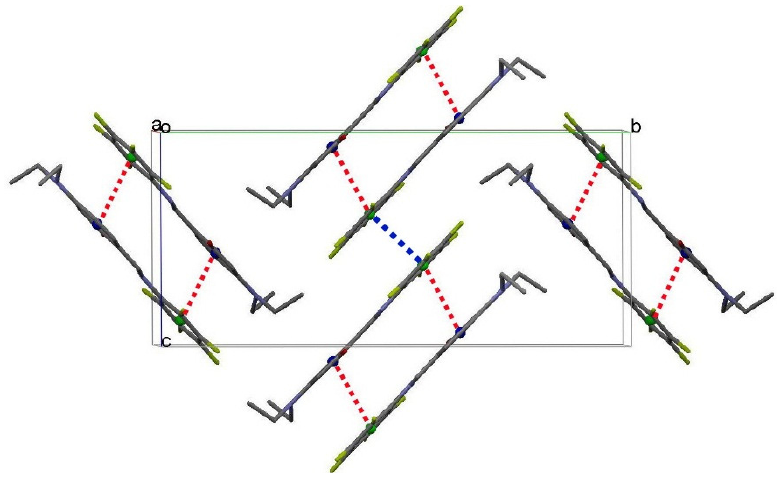
Figure 5. A stereoview of part of the crystal structure of 4 , viewed along the a -axis (all hydrogen atoms are omitted for clarity). Red and blue dashed lines denote the intermolecular π  π interactions. C g1 (blue circles) and C g2 (green circles) are the centroids of the C8–C13 and C1–C6 rings,